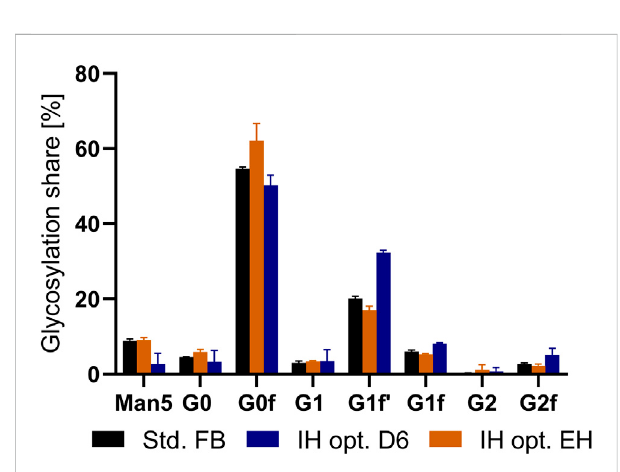
FIGURE 6 Glycosylation distribution in percentage of expressed mAb from a standard fed-batch (FB) process, and the optimized intermediate harvest (IH opt.) at day six as well as the end harvest